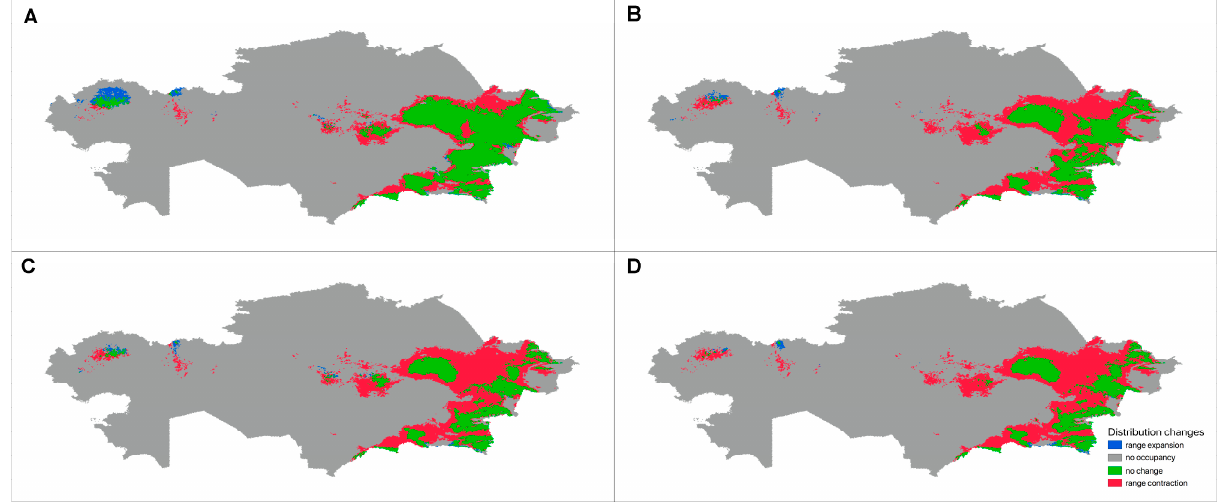
Figure 13. Changes in the distribution of suitable habitats in Kazakhstan for D. umbrosa (Kar. and Kir.) Nevski. and four climate change scenarios—spp126 ( A ), spp245 ( B ), spp370 ( C ), and spp585 ( D ).